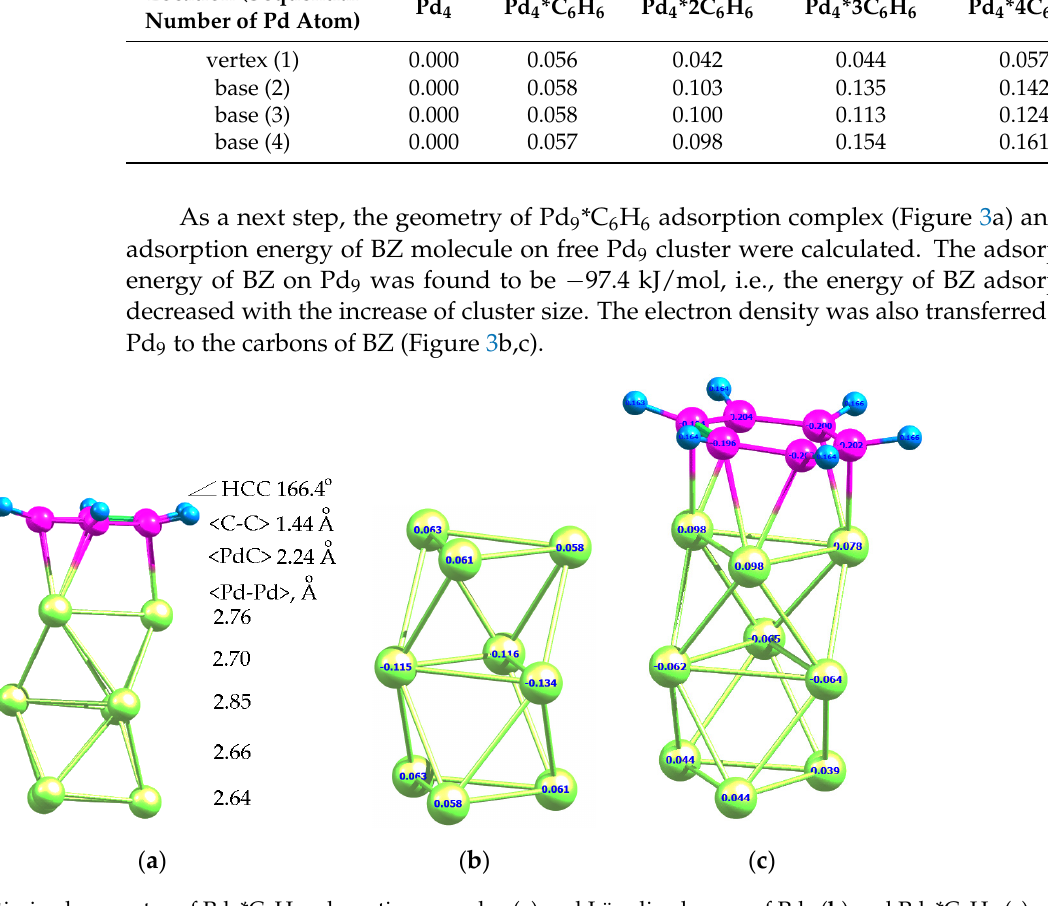
Figure 3. Optimized geometry of Pd 9 *C 6 H 6 adsorption complex ( a ) and Löwdin charges of Pd 4 ( b ) and Pd 9 *C 6 H 6 ( c